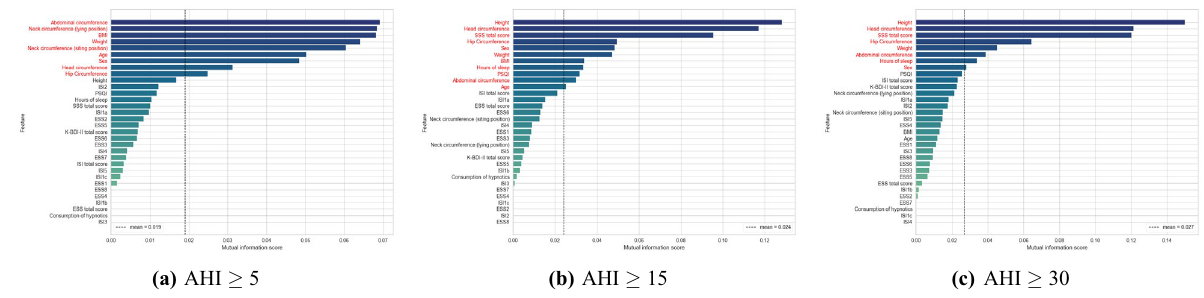
Figure 2. Mutual information (MI) scores for all input features. Each threshold was set as the mean of the mutual information